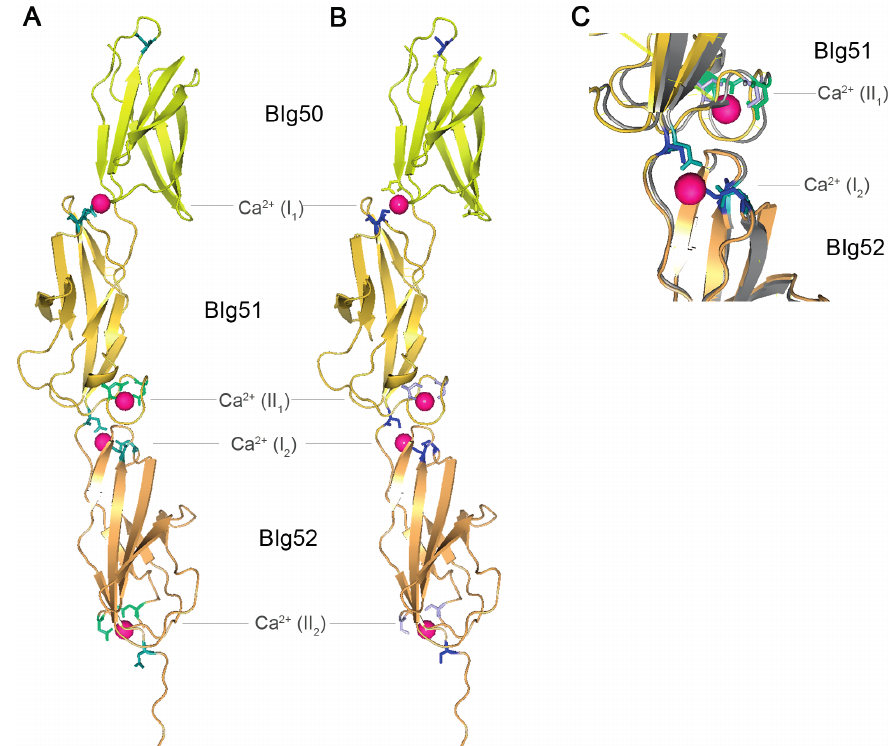
Figure 4. Crystal structure of SiiE BIg50–52. ( A ) Crystal structure of SiiE BIg50–52 with marked conserved aspartate residues. Reproduced, with permission, from Ref. [9]. Conserved D residues of type I Ca 2+ binding sites are shown in teal, conserved D residues of type II Ca 2+ binding sites are shown in green. Bound Ca 2+ ions are depicted in pink; ( B ) Crystal structure of SiiE BIg50–52 with marked conserved aspartate residues exchanged to serine. Conserved D residues of type I Ca 2+ binding sites and conserved D residues of type II Ca 2+ binding sites exchanged to S residues are shown in light blue and blue, respectively. Ca 2+ ions bound by D, but not by S residues, are depicted in pink; ( C ) Close up view and overlay of the type I Ca 2+ binding site at the interface of BIg51 and BIg52 and of the type II Ca 2+ binding site of BIg51 and BIg52 with either conserved D residues (teal and green) or mutated S residues (light blue and blue). 16 D and 24 D (green and light blue) of BIg51 are involved in the type II Ca 2+ binding site, whereas 117 D of BIg52 and 43D and 97 D (teal and blue) of BIg52 are involved in the type II Ca 2+ binding site of BIg51. The protein backbone shown in grey belongs to SiiE with conserved D residues, whereas the yellow backbone belongs to SiiE with the D to S exchanges. Ca 2+ ions bound by D, but not by S residues, are depicted in pink. PyMol was used for the generation of the structure